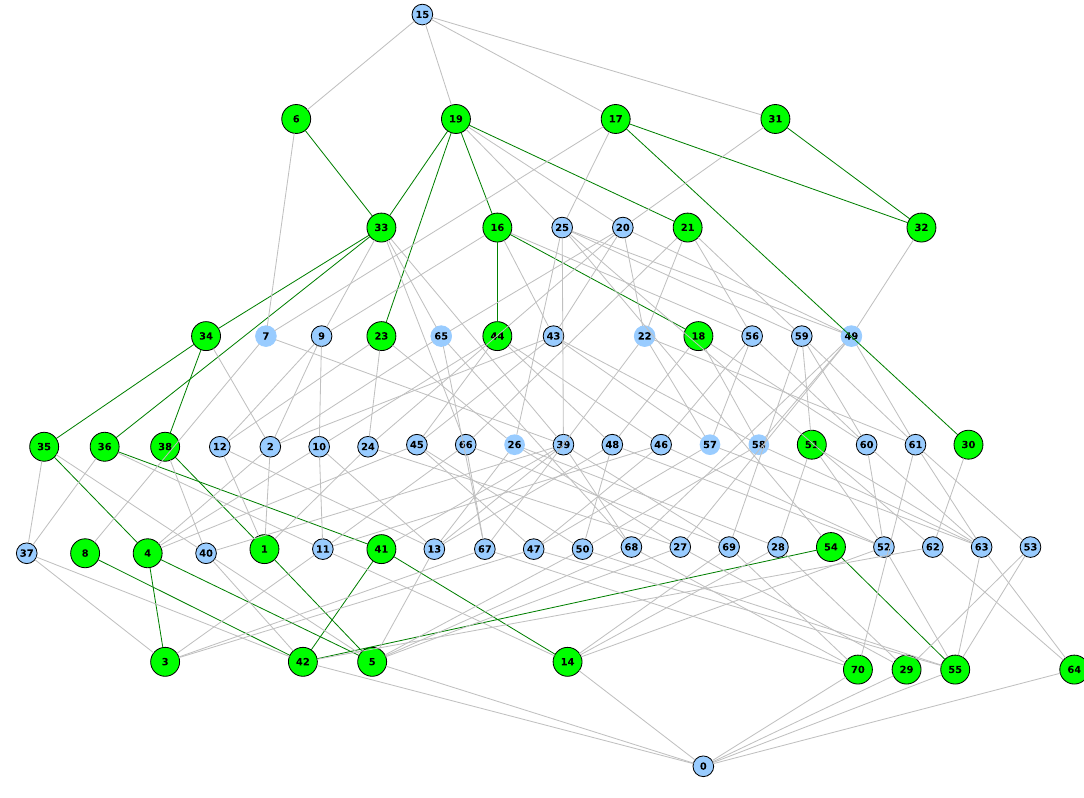
Figure 1: Conceptualization of “game balancing” as a lattice form diagram ParadigmPlus (2020)